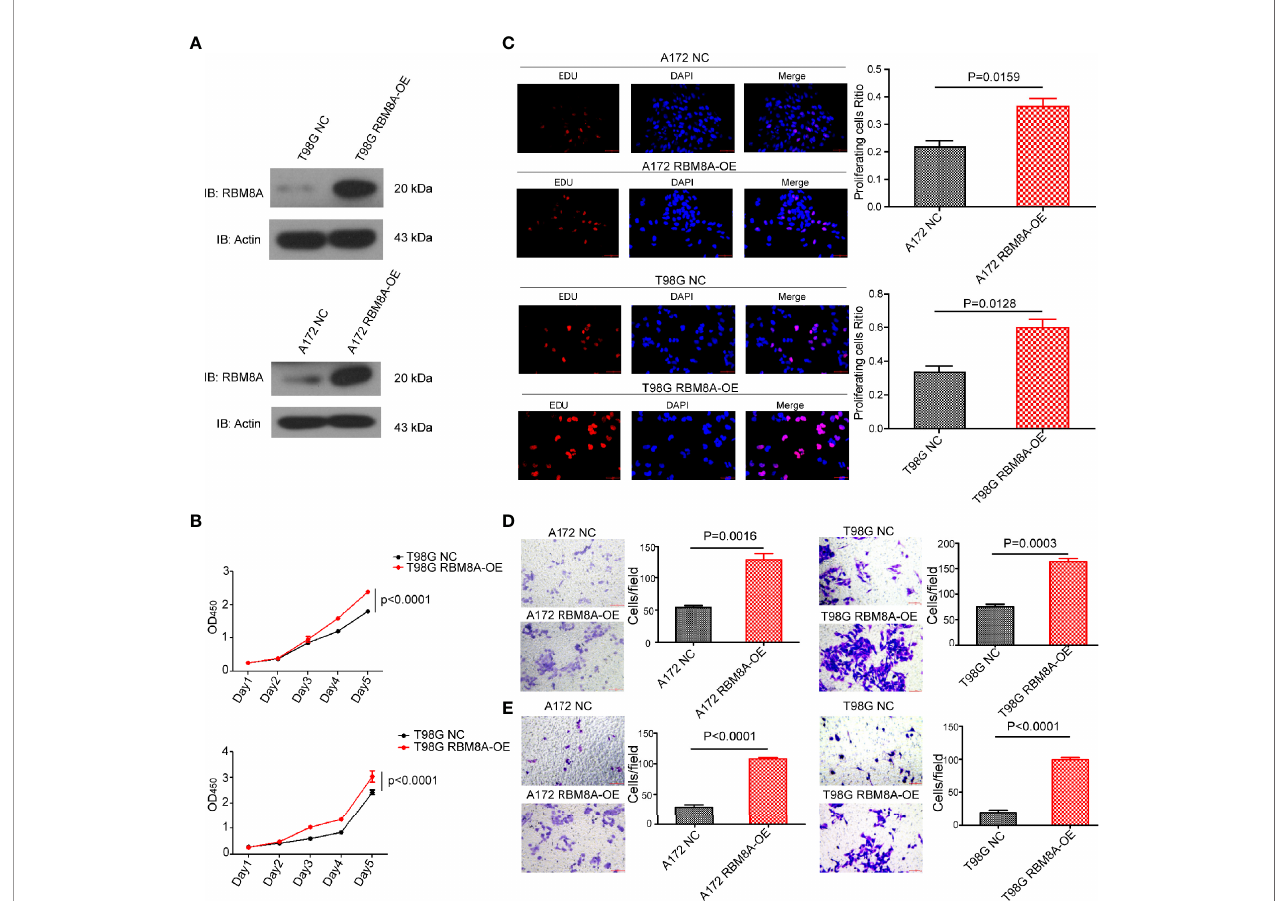
FIGURE 3 | Effects of RBM8A overexpression on proliferation of A172 and T98G GBM cells and their invasive activity. (A) Expression of RBM8A in T98G cells transformed with control lentivirus (NC) or lentivirus expressing RBM8A (RBM8A-OE) was assessed by western blotting. (B) Cell proliferation was analyzed using the CCK8 assay as indicated. (C) Cell proliferation was also measured using the EdU assay. Representative fl uorescence micrographs of the different cell cultures are shown. (D) Transwell analysis with or without RBM8A overexpression. (E) Matrigel-Transwell analysis with or without RBM8A overexpression. All micrographs are shown at 200× magni fi